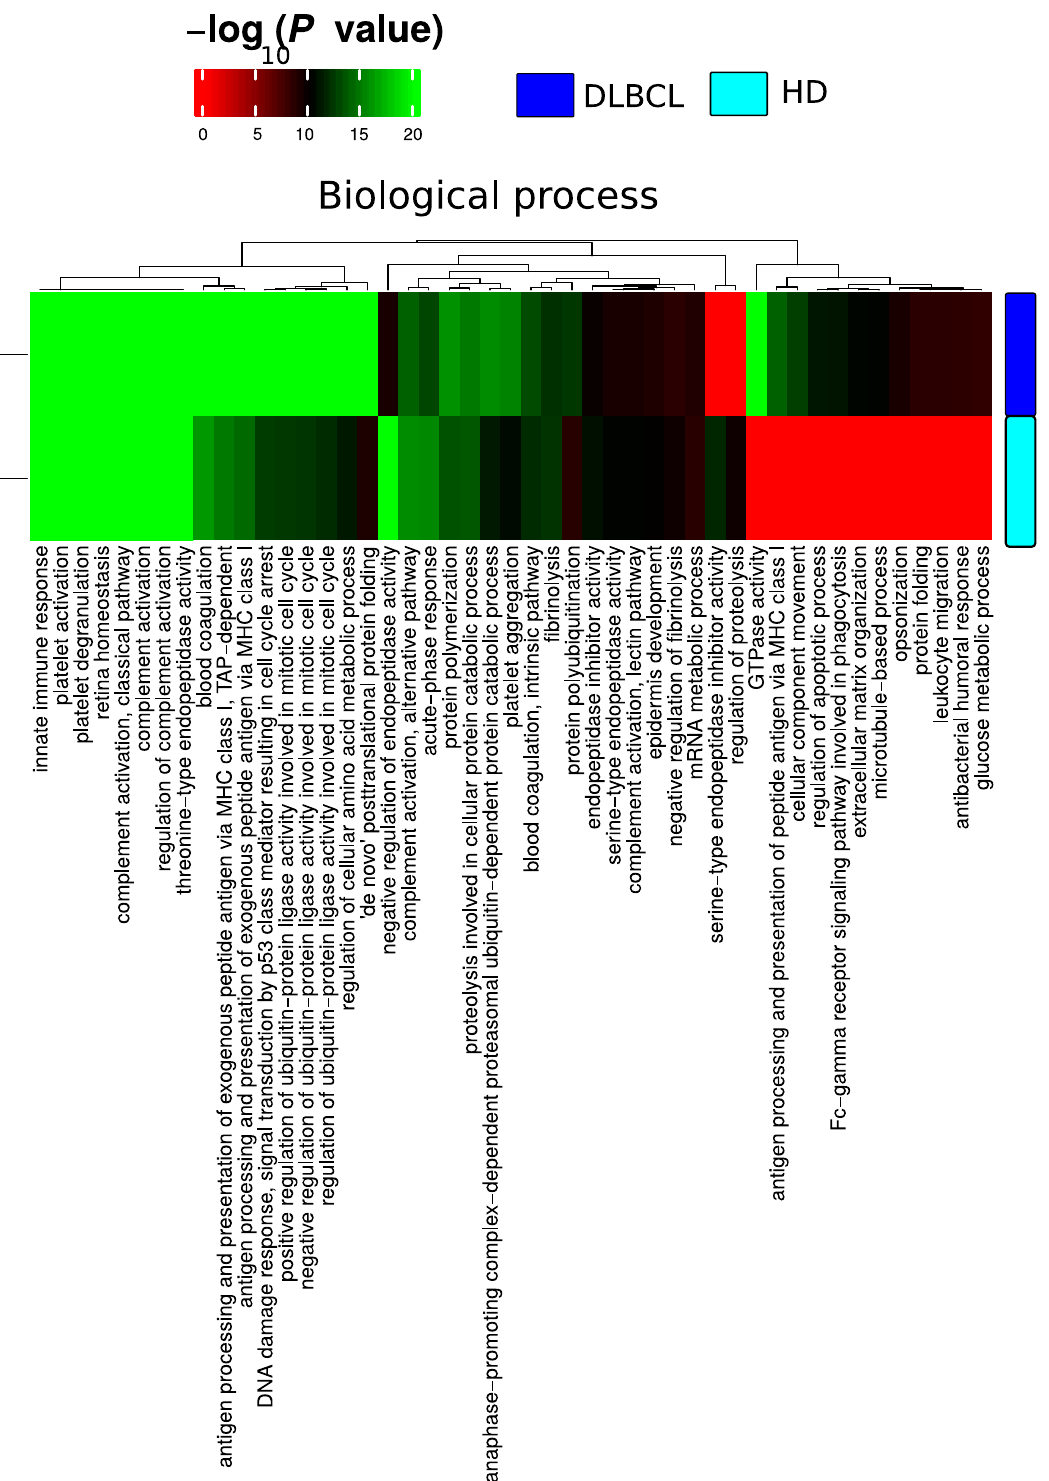
Figure A3. Summary of functional categories that are either enriched in HD or DLBCL based on functional enrichment in all identified protein from DLBCL and HD when compared with the biological process.